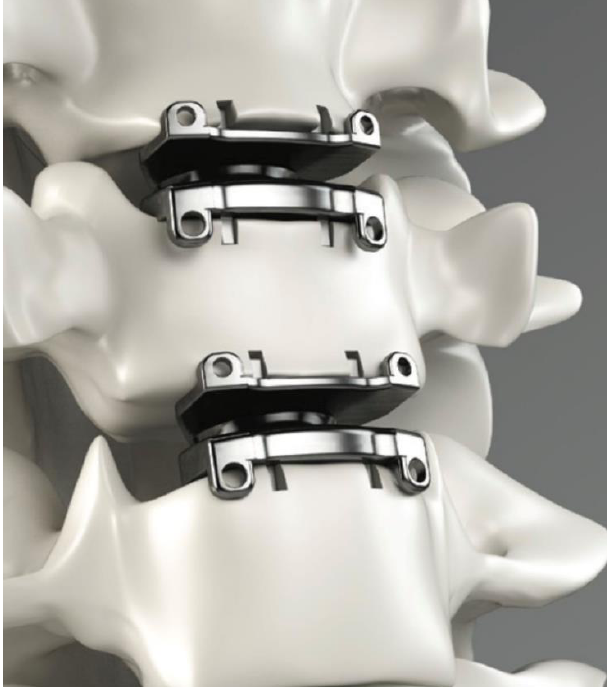
Figure 2. Cervical disc arthroplasty implants placed in two consecutive levels. Printed with permis- sion from Medtronic PLC (Minneapolis, MN, USA).